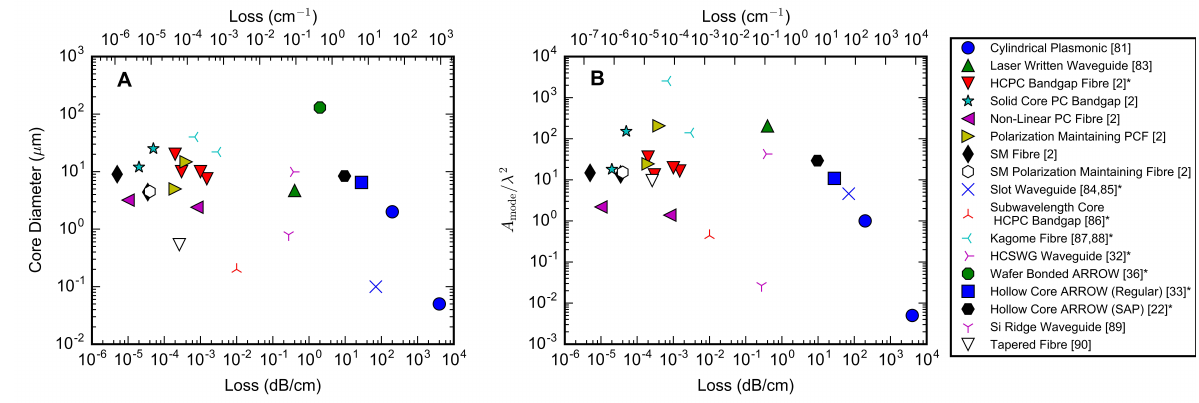
Fig. 1. The core diameter (A) and normalized propagating mode area (B) plotted against the propagation loss for the most common types of optical waveguides that are available off-the-shelf [2] or have been demonstrated experimentally (* indicates waveguides with air-guided fundamental modes, SM = Single Mode).